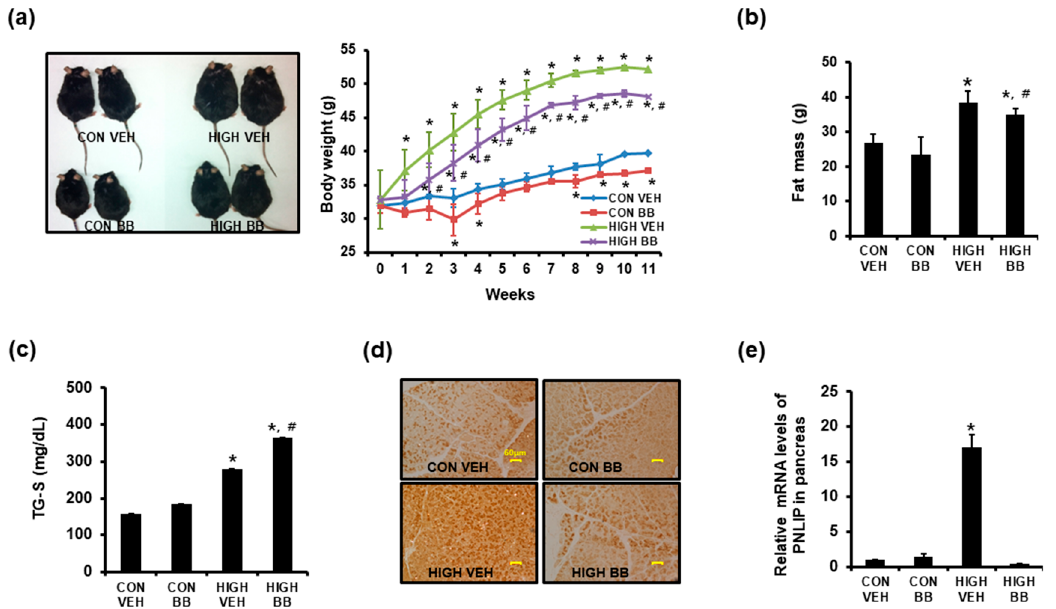
Figure 1. Propranolol attenuated high fat diet-induced body weight/fat mass increase and PNLIP expression. ( a ) The body weights over the 12 weeks of feeding of the high fat diet (HIGH) or the normal diet (CON), in mice administered the vehicle (VEH) or propranolol ( β blocker, BB); ( b ) Total body fat mass at week 12. The bars that share the same letters are not significantly different; ( c ) Propranolol further enhanced the high fat diet-induced increase in fecal triglyceride (TG) excretion; ( d ) Pancreatic tissues were immunostained with an antibody to PNLIP ( × 200). The pancreatic acinar cells positive for PNLIP expression were stained brown; ( e ) The pancreatic levels of PNLIP mRNA were evaluated using quantitative RT-PCR. For all experimental animal groups, N = 10. * p < 0.05 vs. CONVEH, # p < 0.05 vs. VEH within the same diet group. The quantitative RT-PCR data are presented as the means ± S.D. of triplicates.